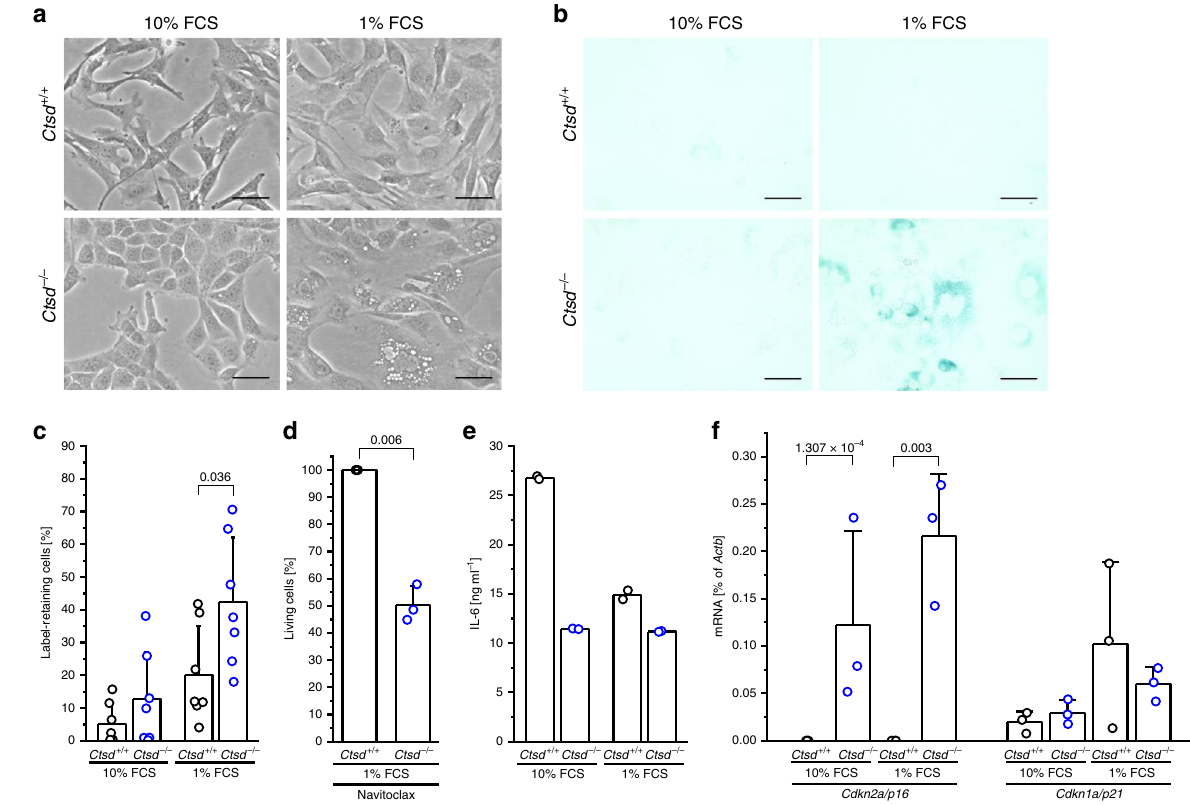
Fig. 3 CTSD de fi ciency induces a quiescent cell state in short-term starved tumor cells. a Pictures of Ctsd + / + and Ctsd − / − PyMT cells cultured for 7 – 10 days in 10% FCS or 1% FCS medium. Bars, 50 μ m. Representative of 5 independent experiments. b Staining for acidic β -galactosidase in 10% FCS and 1% FCS Ctsd + / + and Ctsd − / − PyMT cells. Bars, 50 μ m. Representative of 3 independent experiments. c Quanti fi cation of label-retaining cells among 10% FCS and 1% FCS Ctsd + / + and Ctsd − / − PyMT cells ( n = 7 independent experiments; two-sided two-sample t -test). d Amount of Annexin-V - 7-AAD − (living) cells among 1% FCS Ctsd + / + and Ctsd − / − PyMT cells treated with Navitoclax, relative to DMSO control and Ctsd + / + ( n = 3 independent experiments; two-sided one-sample t -test). e Quanti fi cation of IL-6 by alphaLISA in cell-conditioned media from 10% FCS and 1% FCS Ctsd + / + and Ctsd − / − PyMT cells ( n = 2 independent experiments). f Relative Cdkn2a/p16 and Cdkn1a/p21 expression determined by RT-PCR in 10% FCS and 1% FCS Ctsd + / + and Ctsd − / − PyMT cells ( n = 3 independent experiments; two-sided two-sample t -test). Bar charts show all data points with mean + SD and p -value. Source data are provided as a Source Data fi